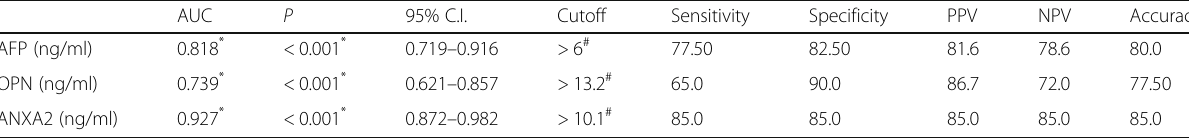
Table 3 Agreement (sensitivity, specificity) for AFP, OPN, and ANXA2 to diagnose HCC